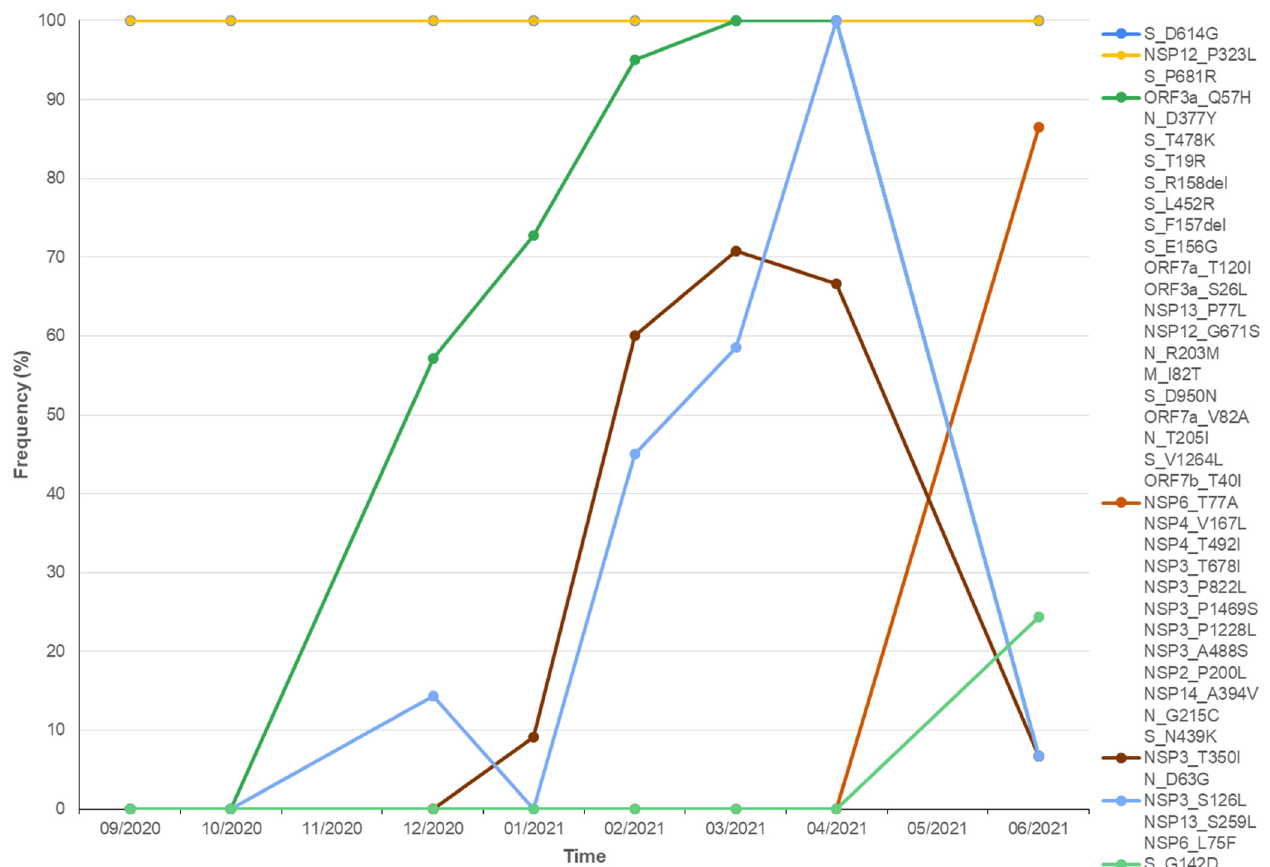
Figure 5. Dynamics of hotspot mutations of SARS-CoV-2 samples in this study circulating in West Java over time, from September 2020 to June 2021. The frequency of each hotspot mutation is expressed by dividing the number of the mutation per month with the number of samples in the month. Not all mutations are displayed for proper presentation.